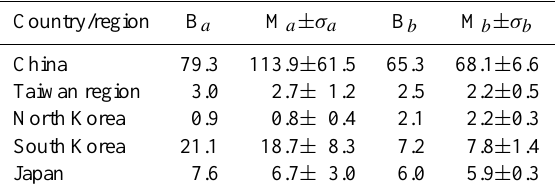
Table 4. HCFC-22 emissions (kt/yr) per country/region for the year 2008. B a and B b are our best estimate a priori and a posteriori emissions, respectively; M a and M b are the mean a priori and a posteriori emissions from all inversions performed, and σ a and σ b are the corresponding standard deviations.